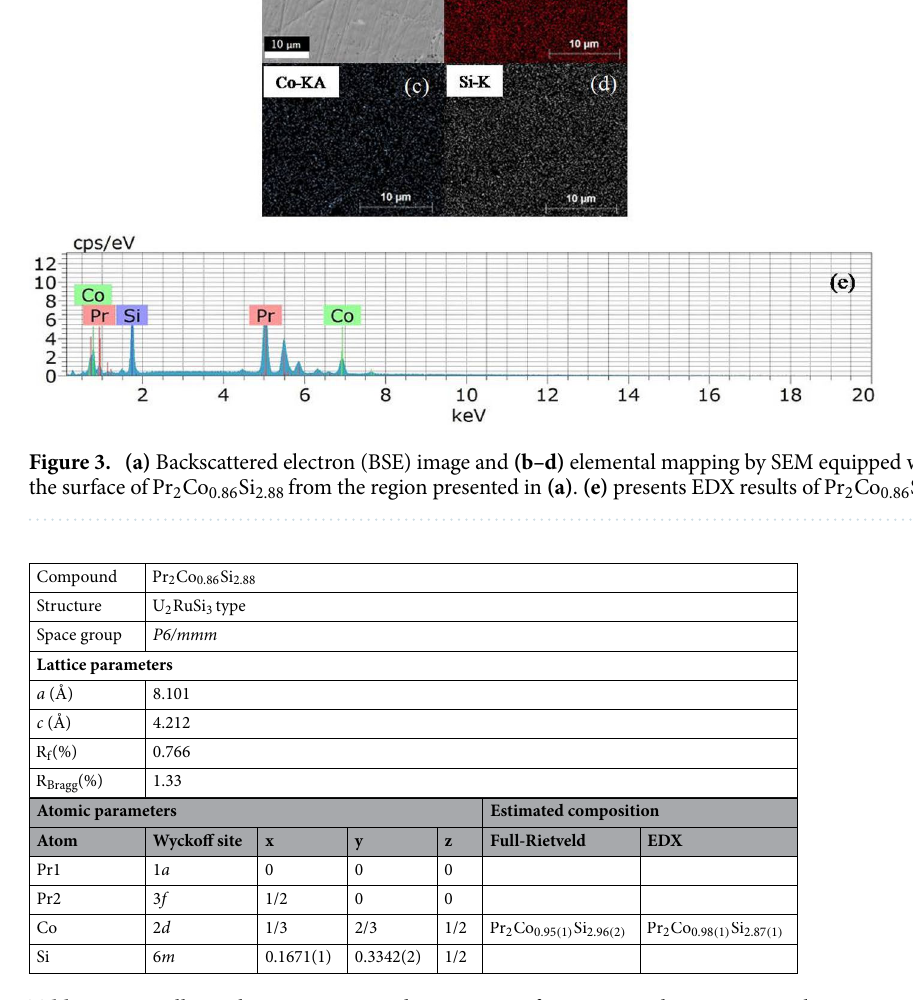
Table 1. Crystallographic parameters and composition from XRD and SEM-EDX analysis at room- temperature.